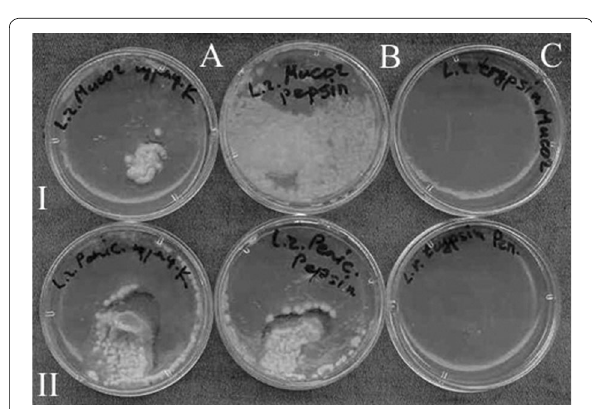
Fig. 4 The effects of different enzymes on antifungal activity of L. rhamnosus MDC 9661. I line—inhibition of M. plumbeus growth. II line—inhibition of P. aurantioviolaceum growth. A MDC 9661 cultural liquid treated by proteinase K, B MDC 9661 cultural liquid treated by pepsin, C MDC 9661 cultural liquid treated by trypsin. For details see “Materials and